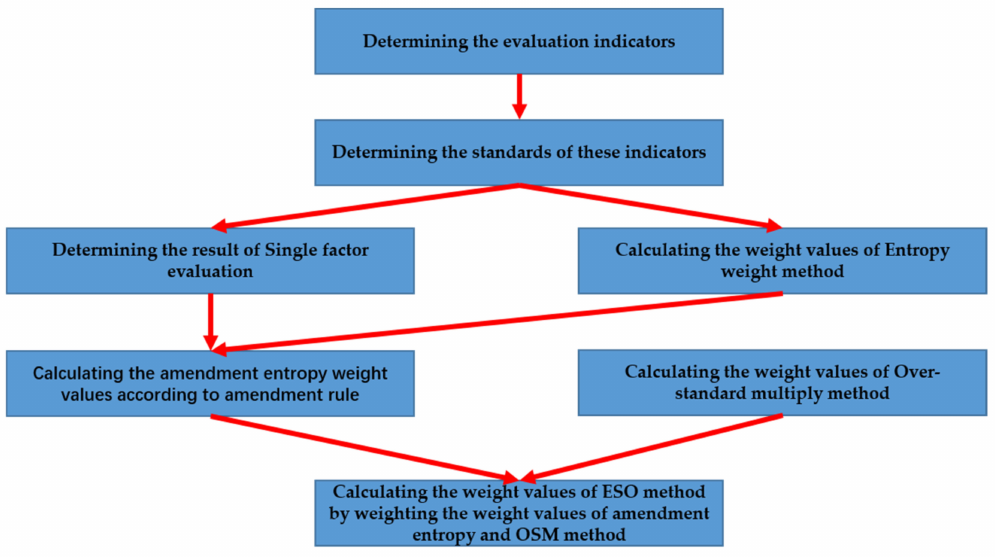
Figure 3. Technical roadmap of ESO